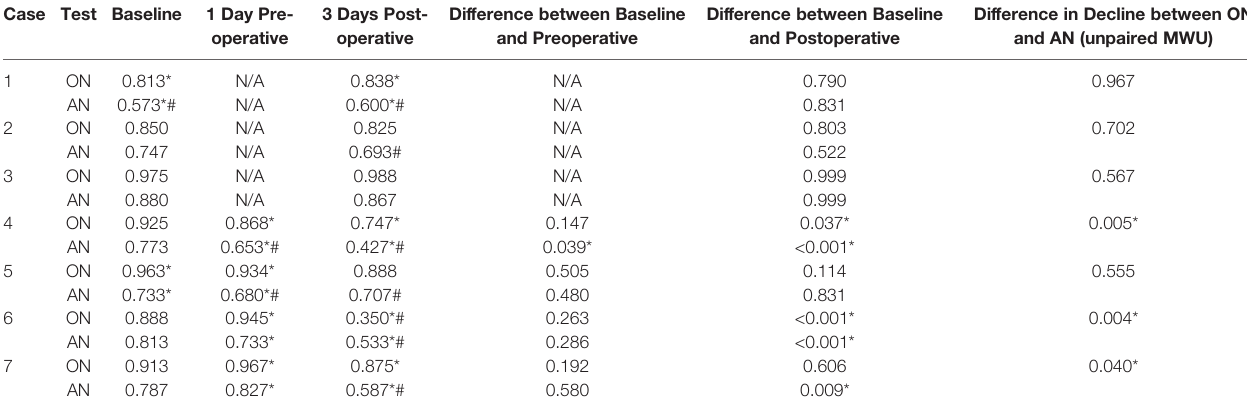
TABLE 3 | Proportion of correctly and fl uently named items in ON and AN across testing